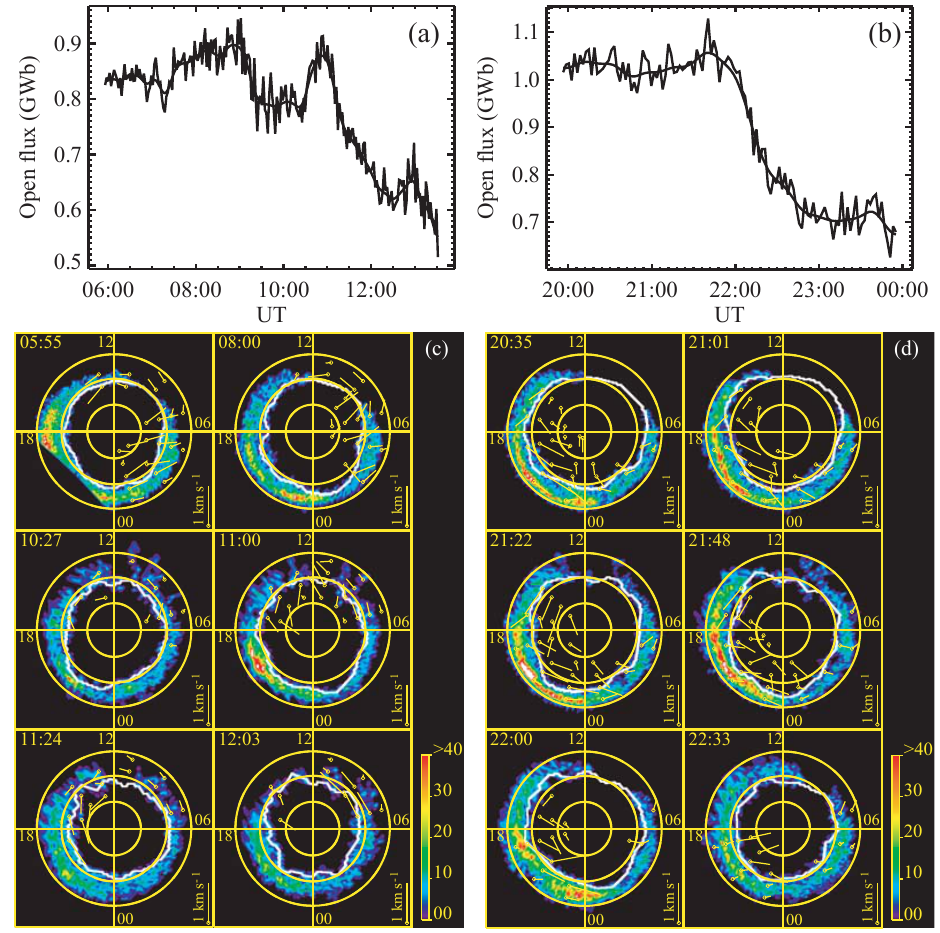
Figure 7. Open magnetic flux estimates using the SI12 images of the proton aurora obtained on 21 August 2000 between (a) 05:55 and 13:30UT and (b) 19:25 and 23:59UT, in the same format as Fig. 3a. SI12 images of the proton aurora in geomagnetic polar view ( c and d ) with the ionospheric convection velocity deduced from SuperDARN observations and with the estimated location of the polar cap boundary, in the same format as Fig. 3b, obtained during the time intervals corresponding to panel (a) and (b) , respectively. The average of the SuperDARN measurements of the ionospheric velocity over the polar caps shown is, in chronological order, 392, 467, 212, 332, 364, 428, 493, 502, 508, 453, 508 and 319ms − 1